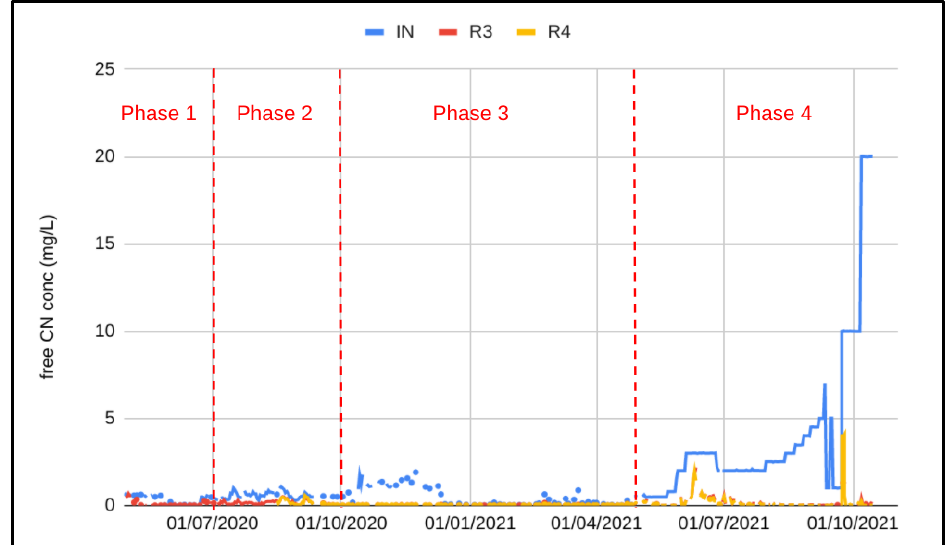
Figure 6. Free cyanide concentration in the pilot influent (IN), out of R3 and out of R4.